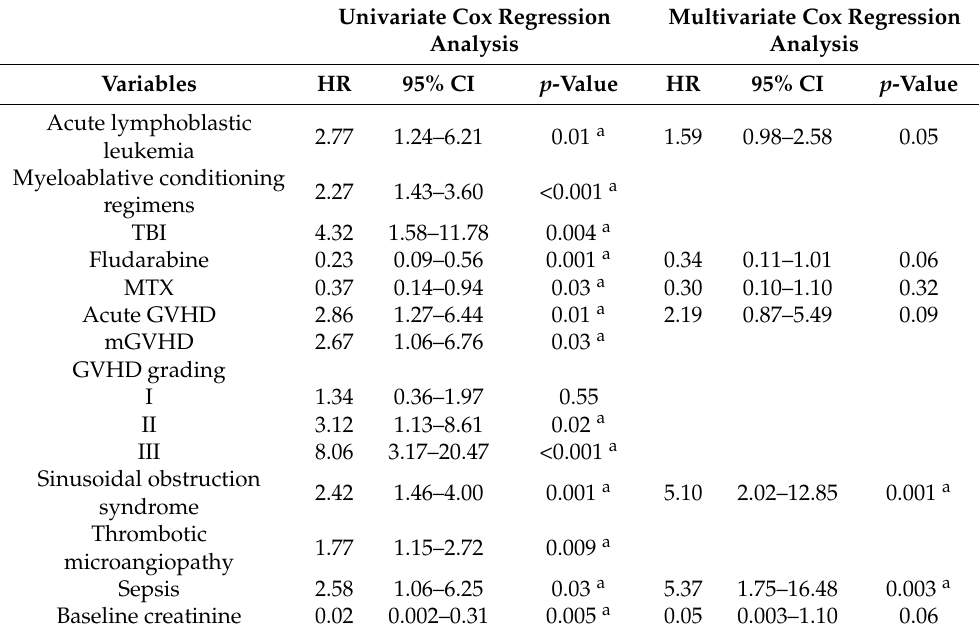
Table 4. Cox regression analysis for evaluation of risk factors associated with AKI stage 3 in the first 100 days after HSCT. Univariate Cox Regression Multivariate Cox Analysis